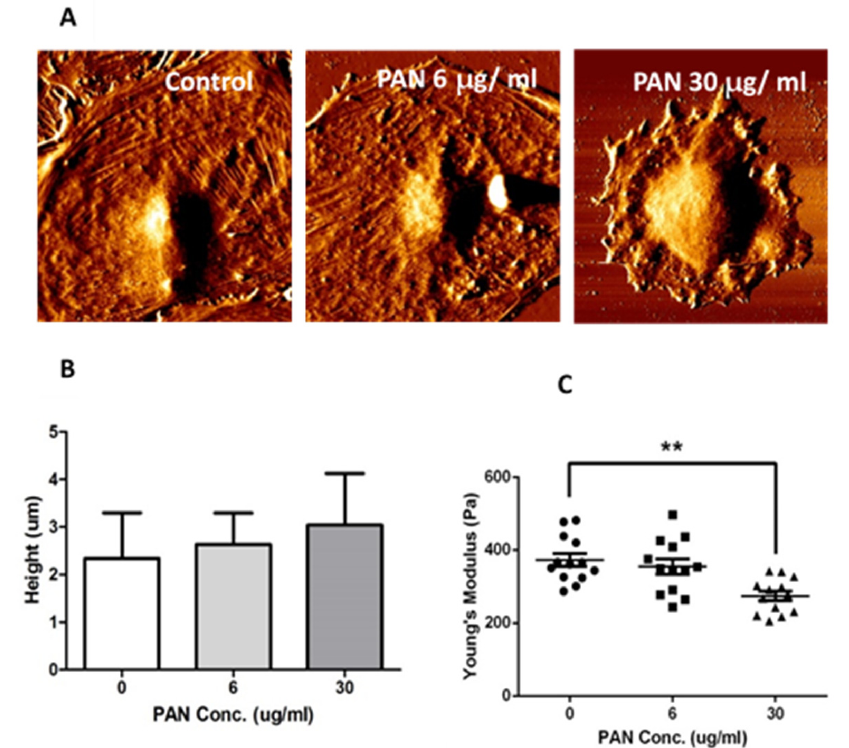
Figure 2. Atom force microscopy (AFM) images of podocytes. ( A ) The actin cytoskeleton network was disrupted after PAN exposure. (PAN = Puromycin aminonucleoside). ( B ) Podocyte height increased slightly with increasing PAN concentrations. (PAN = Puromycin aminonucleoside). ( C ) Podocyte stiffness decreased significantly with increasing PAN concentrations. (PAN = Puromycin aminonucleoside). ** p < 0.01.